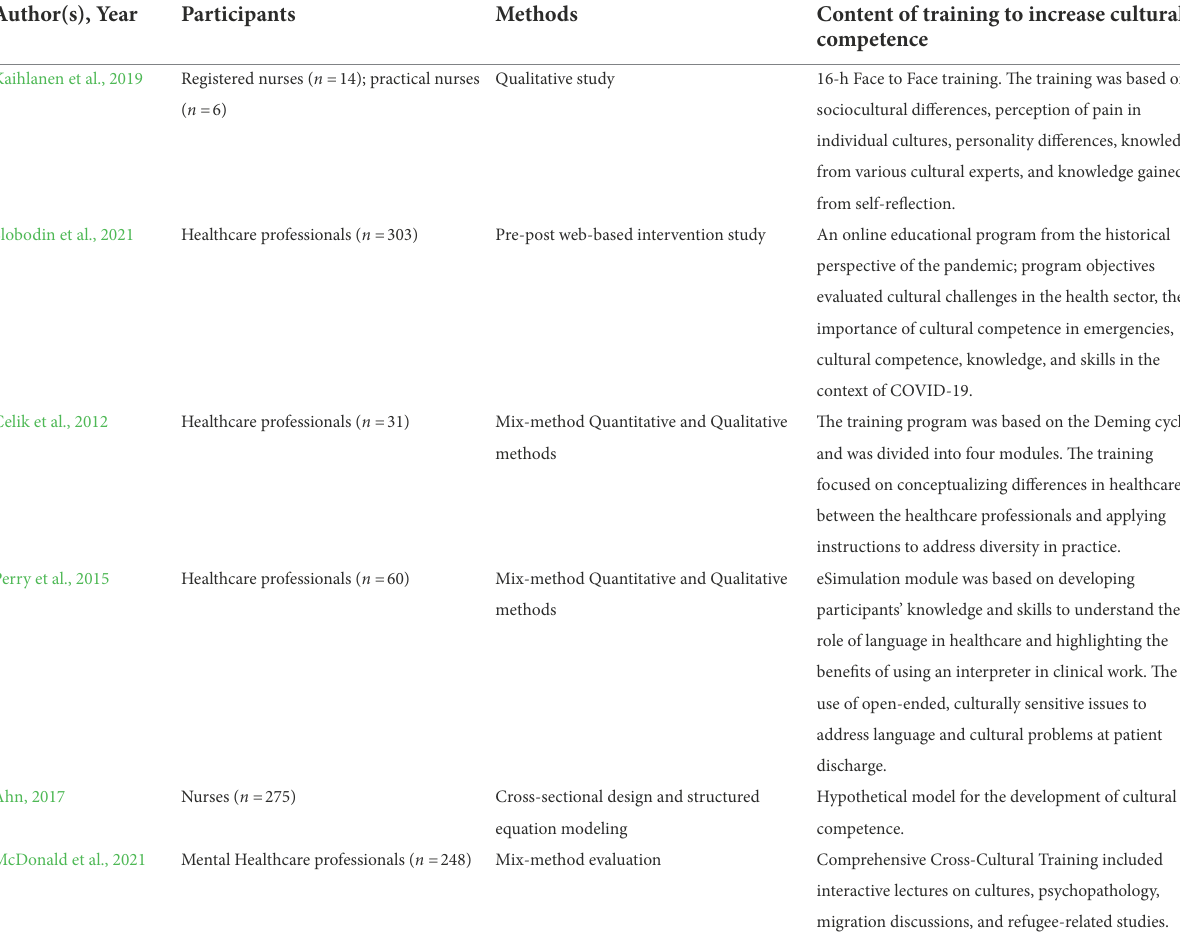
TABLE 3 Characteristics of included